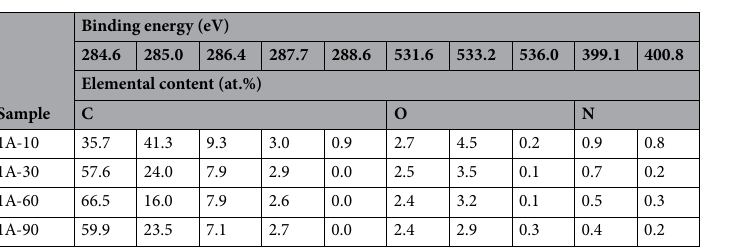
Table 3. Chemical composition analyzed using high-resolution XPS for series